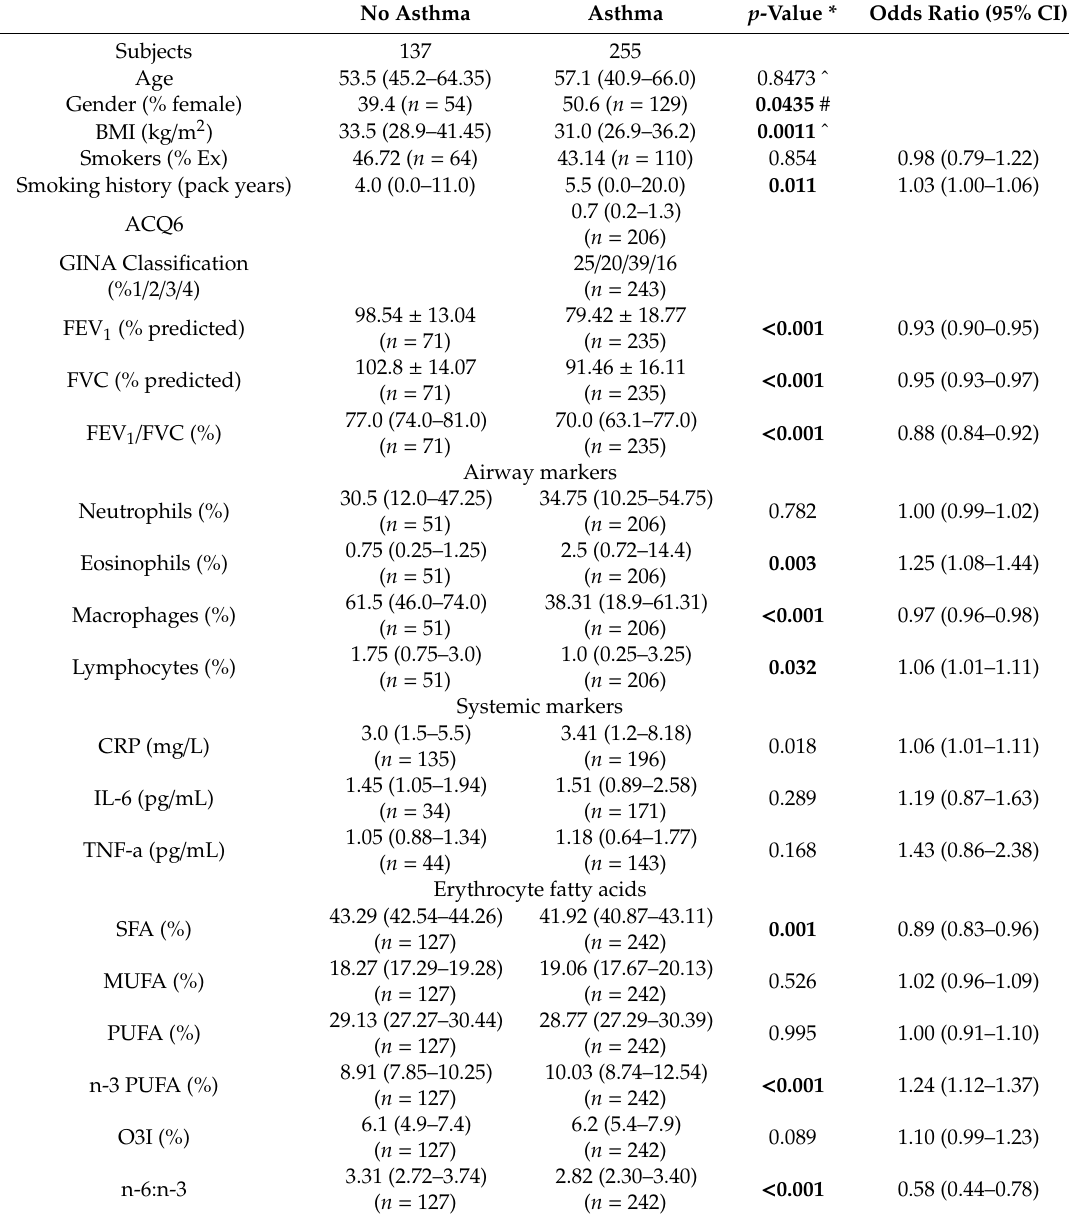
Table 1. Subject